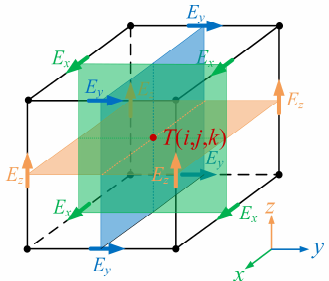
Figure 2. Spatial distribution of thermal field node and EM field components.